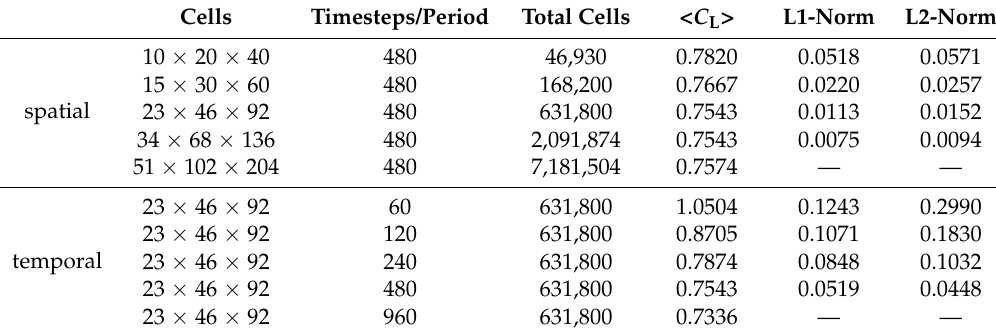
Table 1. Spatial and temporal sensitivity for 3D grids. Five different meshes and five timestep sizes were included in the spatial and temporal sensitivity study. The medium grid (23 × 46 × 92) with 631,800 cells was chosen with 480 timesteps/period for the NSe simulations. Cells Timesteps/Period